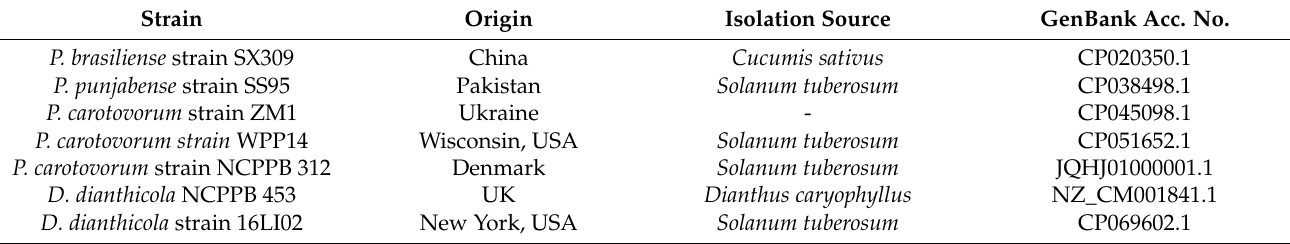
Table 3. Pectobacterium genomes selected for genetic